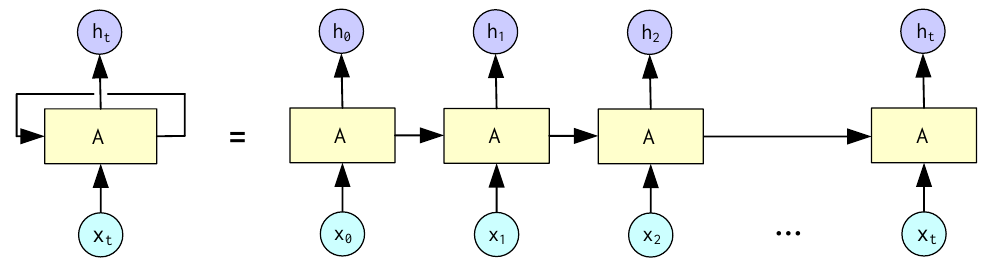
Figure 2. RNN network structure unfolded along the time line.